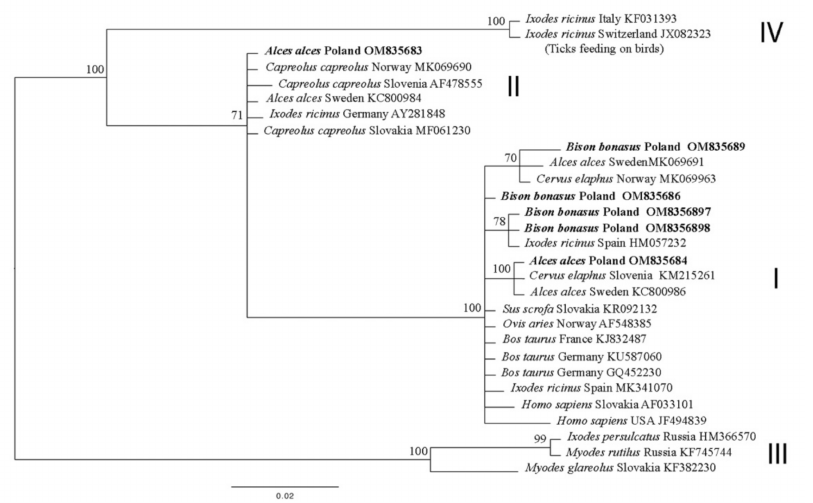
Figure 2. Phylogenetic tree of groEL partial gene (528 bp) haplotypes from Anaplasma phagocytophilum , constructed by Bayesian inference (BI) analysis using MrBayes version 3.2. The HKY + G model was chosen as the best-fitting nucleotide substitution model using JModelTest version 2.1.10 software. The scale bars are proportional to the number of substitutions per site. In bold, sequences from this study. I–IV ecotype of A. phagocytophilum according to Jahfari et al. (2014)